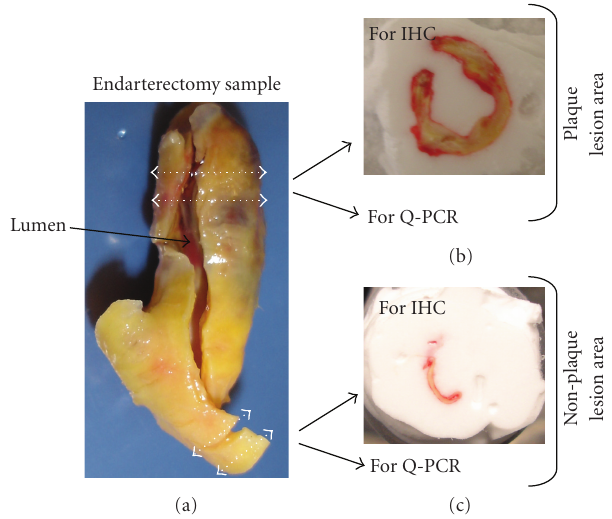
Figure 1: (a) Typical macroscopic pictures of a carotid endarterec- tomy specimen. (b) A transverse (perpendicular to the lumen) section of the internal carotid artery was taken in the plaque lesion area (PLA) above the bifurcation point. (c) A macroscopically nonplaque area (NPLA) was used as an internal control. The PLA and the NPLA sections were split horizontally giving 2 identical pieces that were used, respectively, for immunohistochemistry and for quantitative